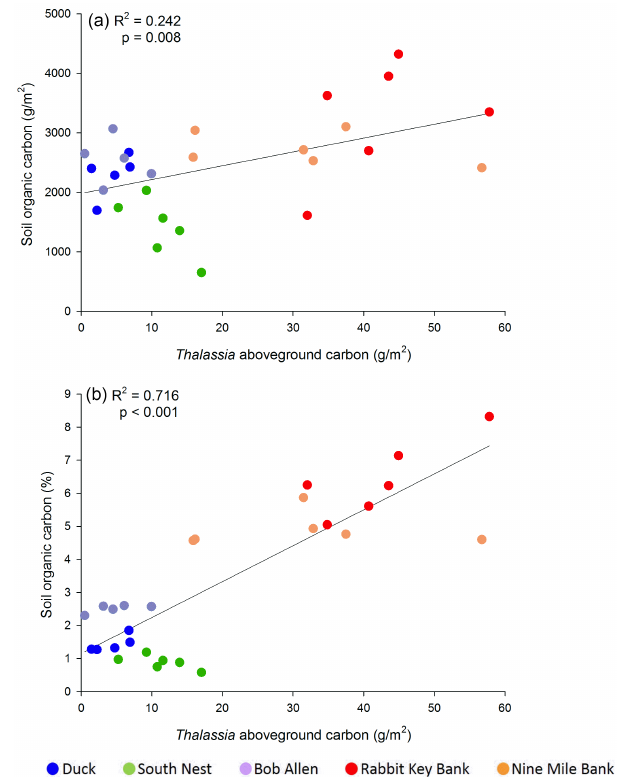
Figure 5. Linear relationship between Thalassia testudinum above- ground carbon stock and soil carbon stock in control plots, reported in (a) gm − 2 and (b) percent. Sites are listed in the legend in order from east (most P limited) to west (least P limited).